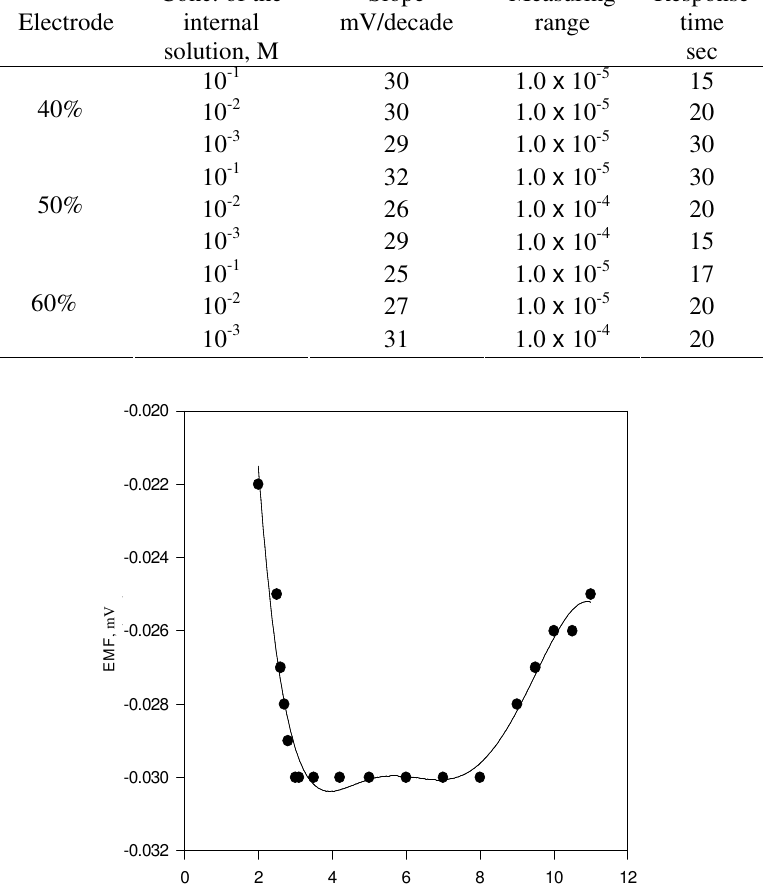
Figure 2 Effect of pH on the response of Gd(III) selective electrode based on ZrWP taking10 -2 M as external